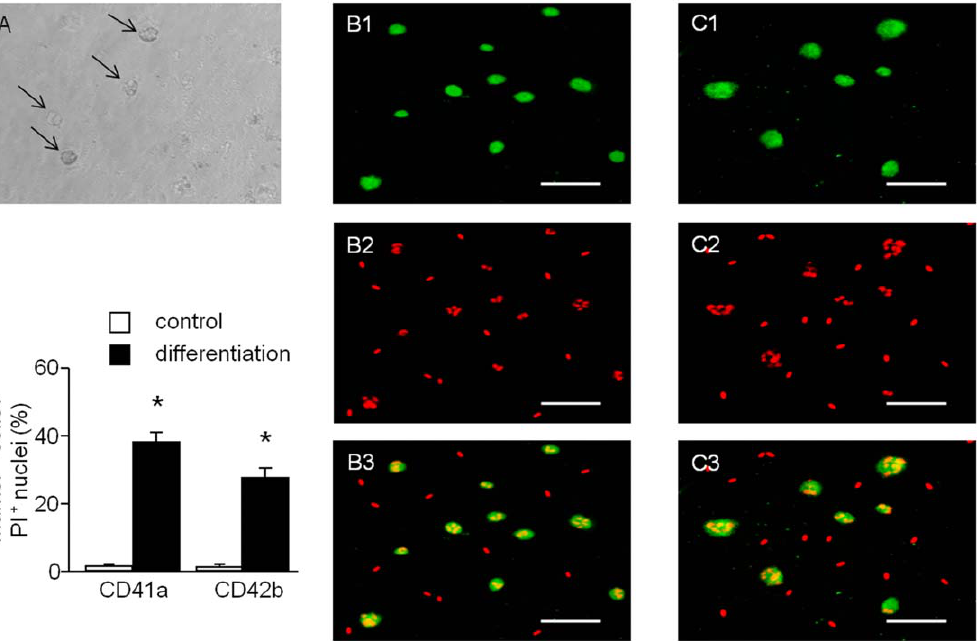
Figure 2. Microscopic analysis of MKs differentiated from hESSCs. MK differentiation can be observed by cell size under light microscope (A: MKs, indicated by black arrows) and determined by immunocytochemistry staining (B1: CD41a; C1: CD42b; B2, C2: PI; B3, C3: merged. scale bar: 75 m m). D, summarized data showing the expression rates are expressed as mean 6 SEM, *P , 0.01, control versus differentiation, n=4/group.